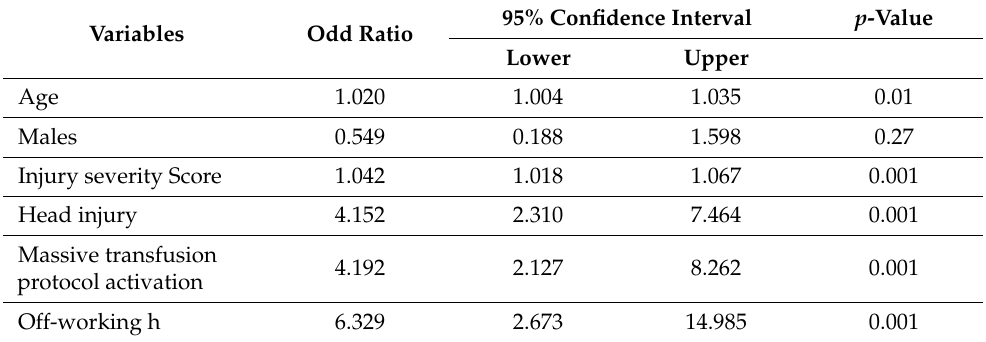
Table 5. Multivariate regression analysis for the predictors of